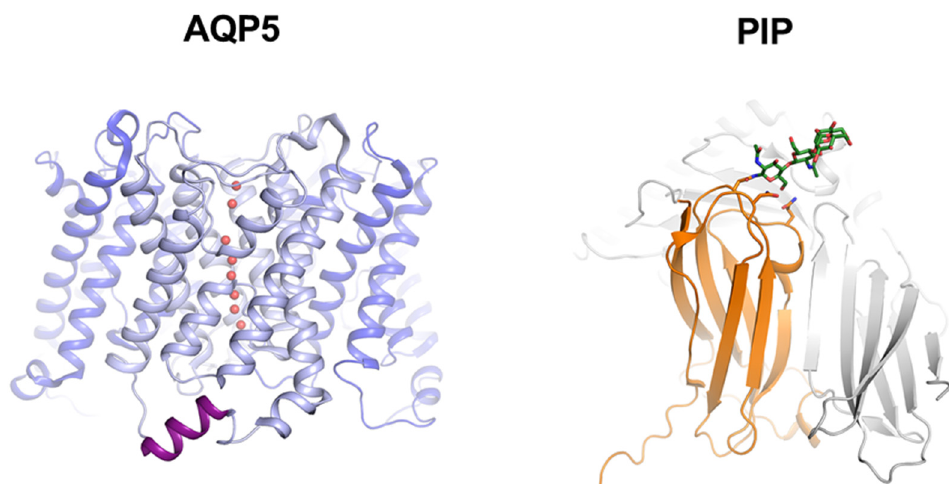
Figure 1. Left : crystal structure of the human AQP5 tetramer (PDB code 3D9S) with one monomer highlighted in light blue and water molecules in red. The C-terminal helix that is known to be involved in protein-protein interactions in other AQPs is highlighted in purple. The last 21 amino acids were not resolved in the crystal structure and are therefore not shown. Right : crystal structure of human PIP (orange) in complex with the Zinc α 2-glycoprotein (ZAG, grey) (PDB code 3ES6). A single glycosylation chain on Asn77 in PIP is shown in green.